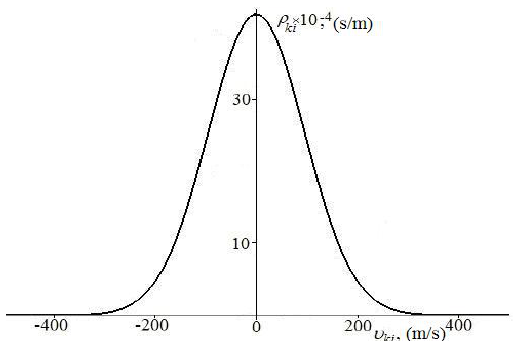
Fig. 2. Velocity distribution function of kinks.